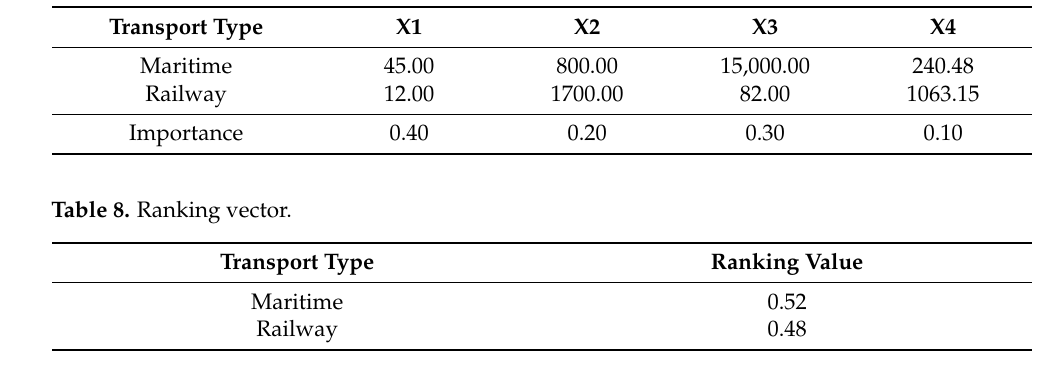
Table 7. Decision matrix for 200 loading units.